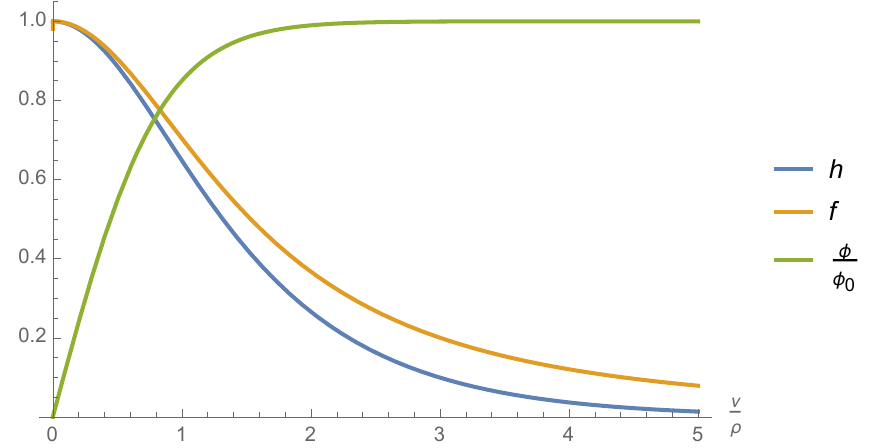
Figure 7 . Graph of the exact double BPS Nielsen-Olesen vortex solution for ( q; l ) = (2 ;